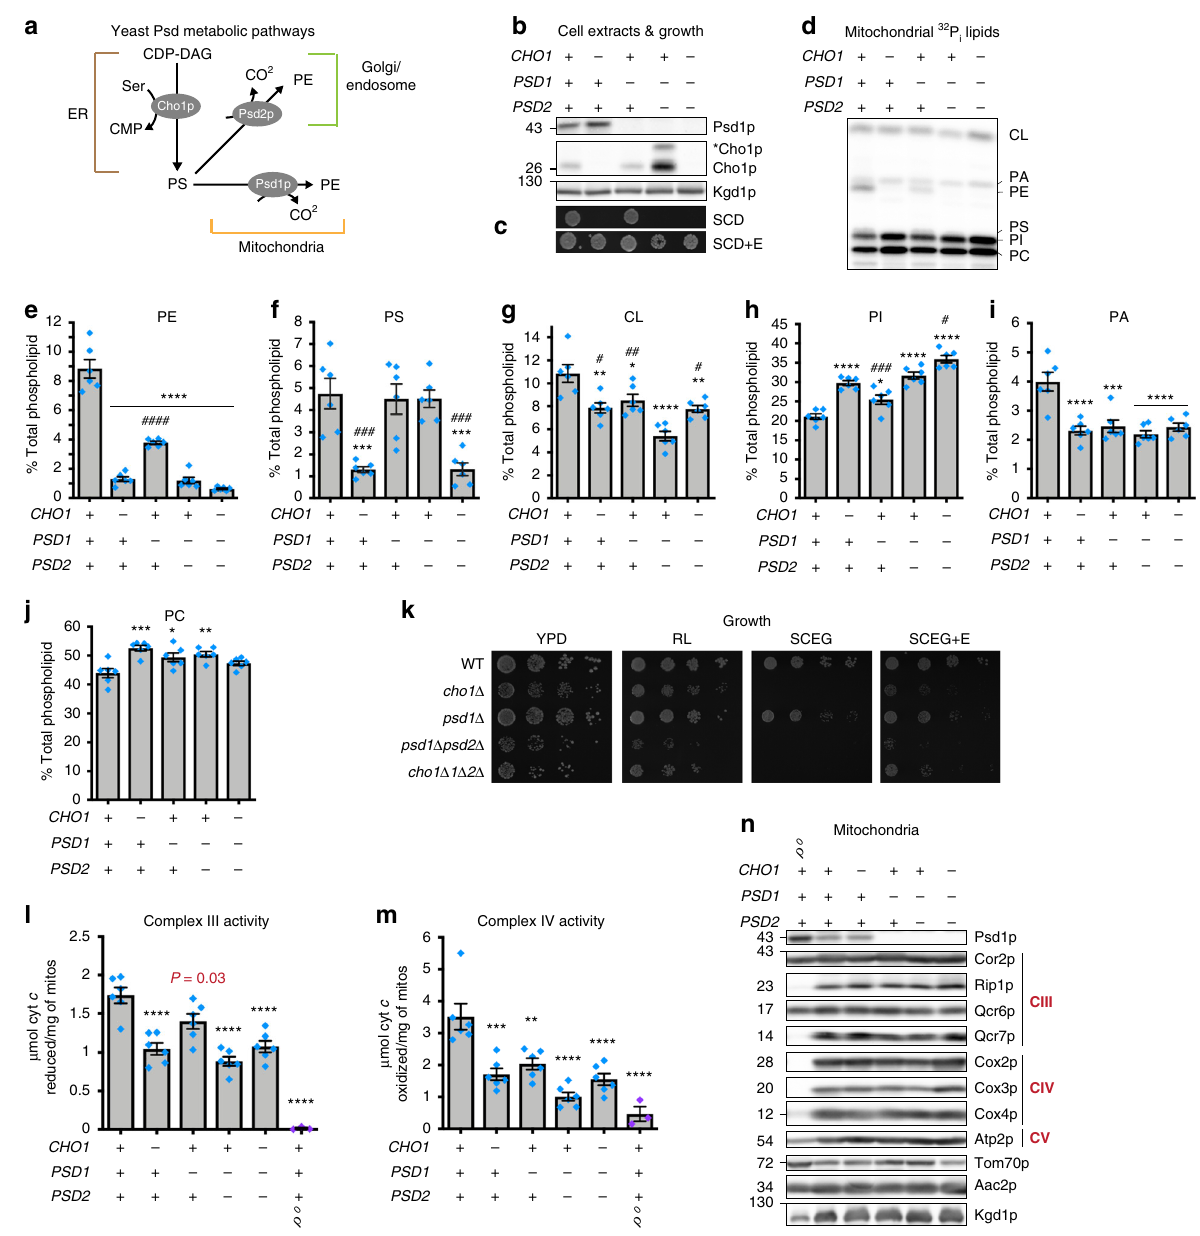
Fig. 8 Deletion of Cho1 impairs complex III and complex IV activities. a Metabolic pathways tied to PS synthesis by Cho1 in yeast. b Detection of the β subunit of Psd1 and Cho1 expression were veri fi ed in yeast whole cell extracts of the indicated strains by immunoblot. Kgd1 served as a loading control. *Cho1, phosphorylated Cho1. c The indicated strains were spotted onto synthetic complete dextrose (SCD) medium with or without ( + / − ) 2 mM ethanolamine ( + E) and incubated at 30 °C for 2 days. d – j Mitochondrial phospholipids from the indicated strains were labeled overnight with 32 P i , separated by TLC, and quantitated by phosphoimaging (mean ± S.E.M. for n = 6 biological replicates). Signi fi cant differences compared to WT (asterisk) or psd1 Δ psd2 Δ (number sign) were calculated by one-way ANOVA with Holm – Sidak pairwise comparisons. k The indicated strains were spotted and incubated at 30 °C for 2 days on YPD and for 3 days on rich lactate (RL), and SCEG without or with 2 mM ethanolamine ( + E). l Complex III activity and ( m ) complex IV activity in isolated mitochondria solubilized in 0.5% (w/v) DDM (mean ± S.E.M. for n = 6 biologically independent experiments, except for ρ 0 , n = 3). Analysis vs. WT by one-way ANOVA with Tukey ’ s multiple comparison test. n Steady state expression of mitochondrial proteins in mitochondria isolated from the indicated